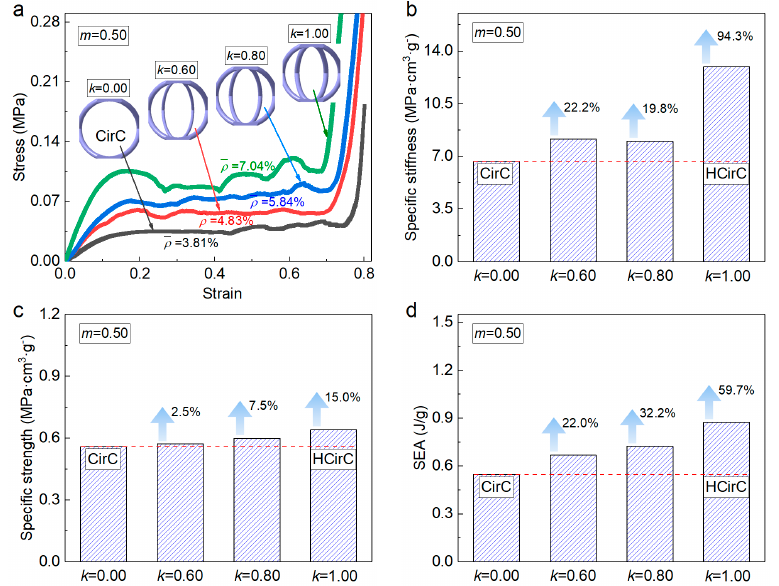
Figure 15. Effect of parameter k on the mechanical performance of hierarchical lattice structure HCirC: ( a ) stress–strain curves; ( b ) specific stiffness; ( c ) specific strength; ( d ) SEA.